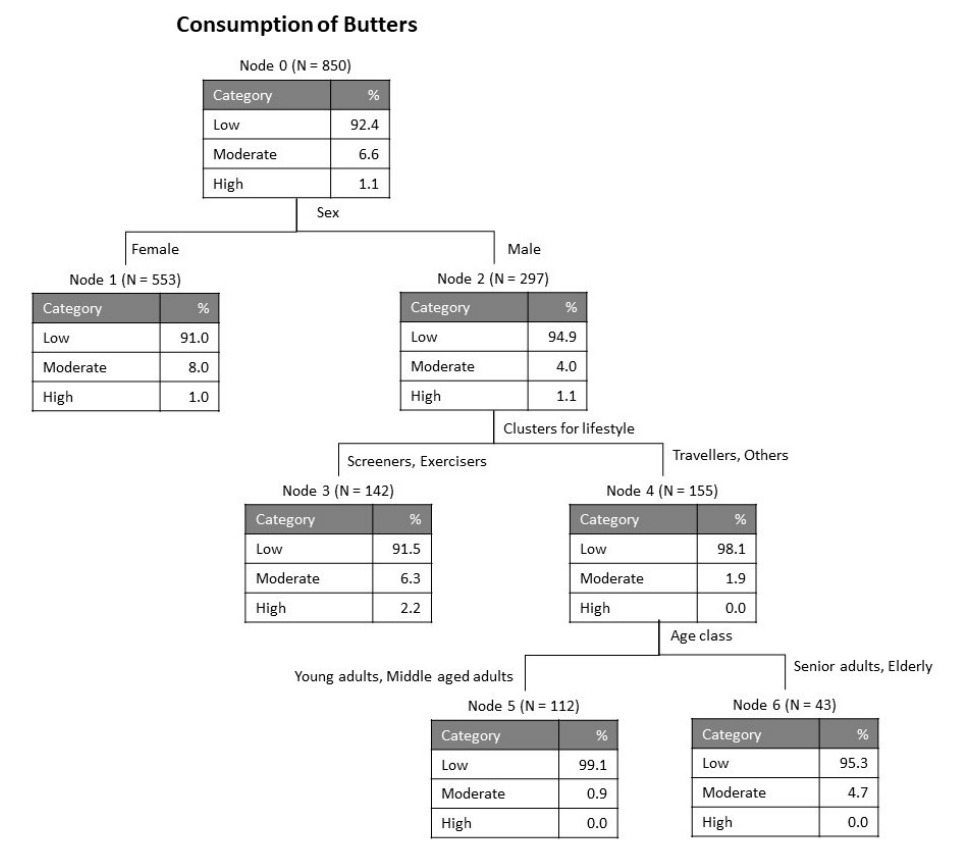
Figure 3. Tree classification for consumption of butters.